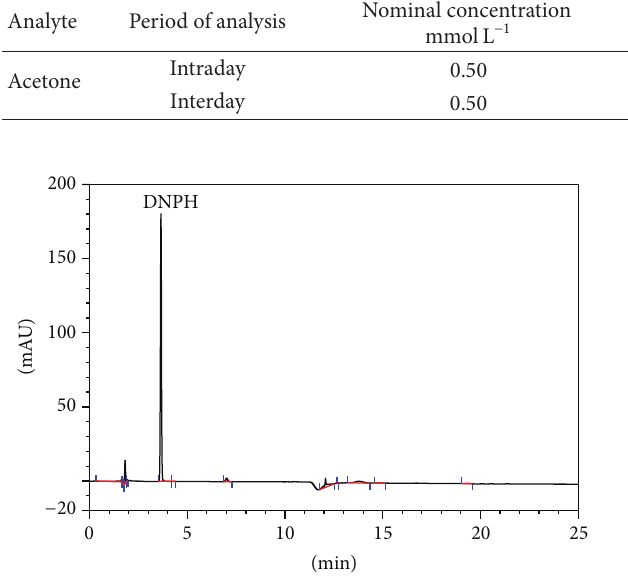
Figure 1: The chromatogram of 2,4-DNPH; for chromatographic conditions: see Section 2.